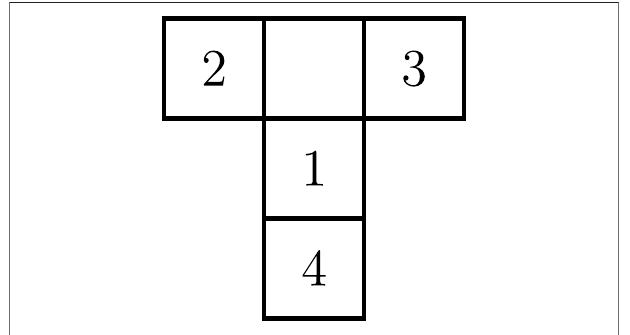
FIGURE 3 | Layout of the T-maze. The agent starts at position 1. The reward is located at either position 2 or 3. Position 4 contains a cue which indicates the reward position.